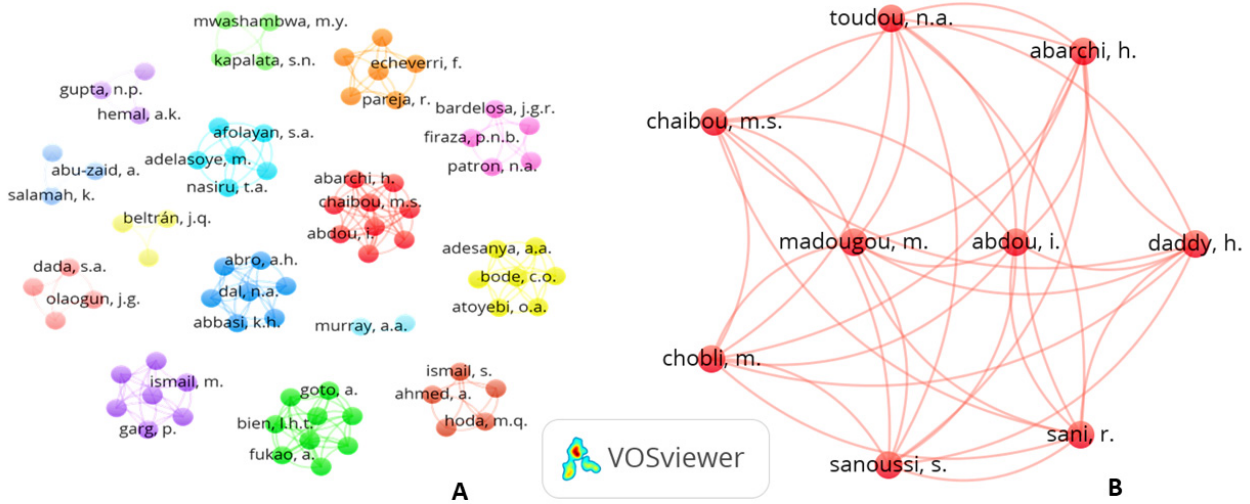
Figure 10. Clusters of authors. ( A ) Connection strength between authors ( B ) Map of the network of